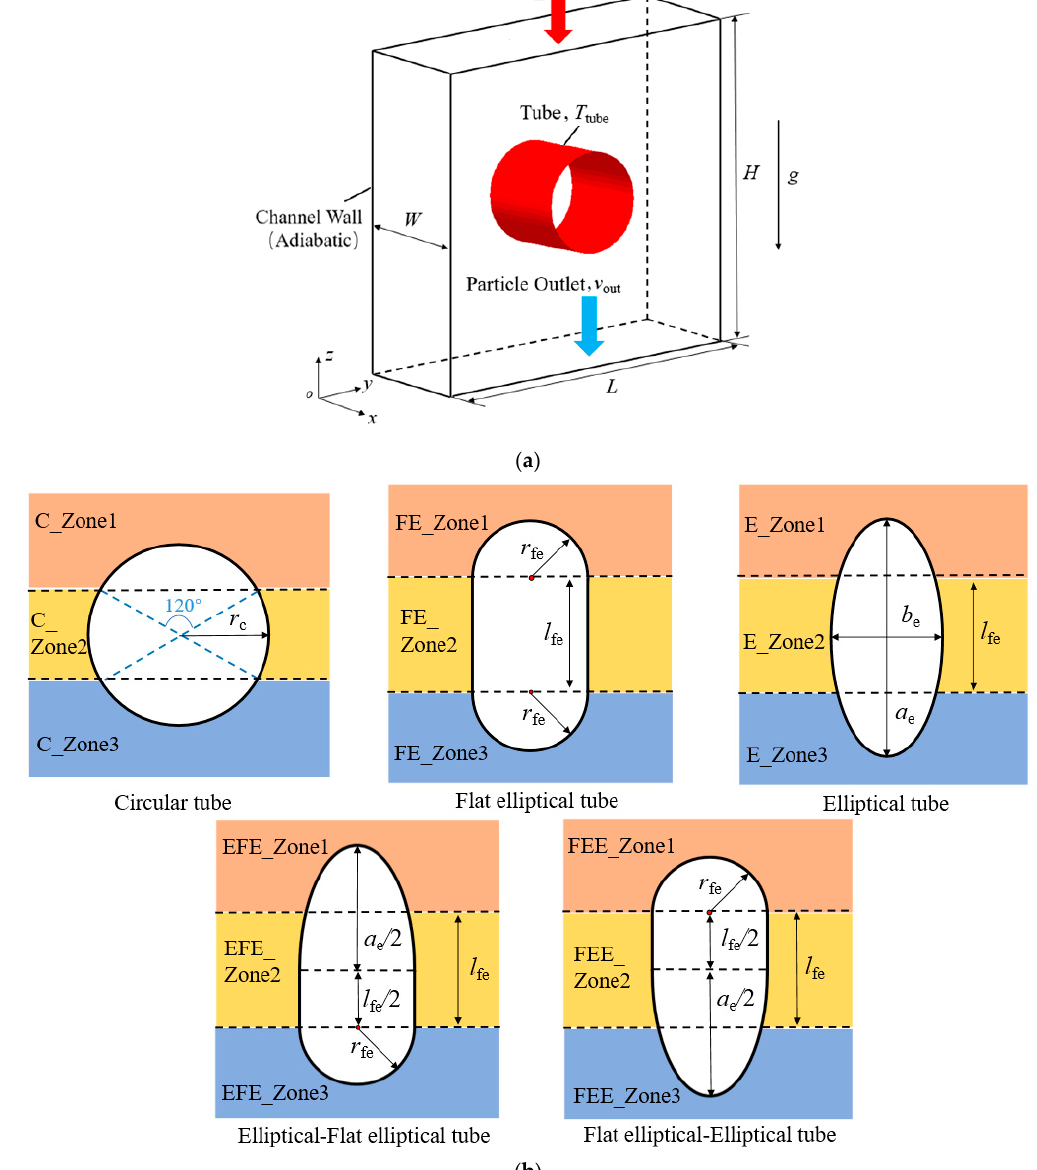
Figure 1. Physical model and cross section zones for particle flow around different tubes: ( a ) Physical model; ( b ) Cross section zones for different tubes.